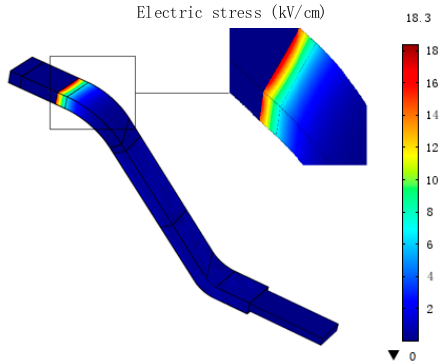
Figure 4. Electric field distribution of the linear corona protection structure.